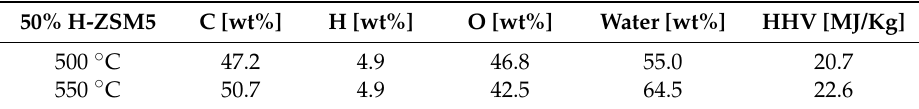
Table 5. Effect of the pyrolysis reaction temperature on the characteristics of the liquid 1 . 50% H-ZSM5